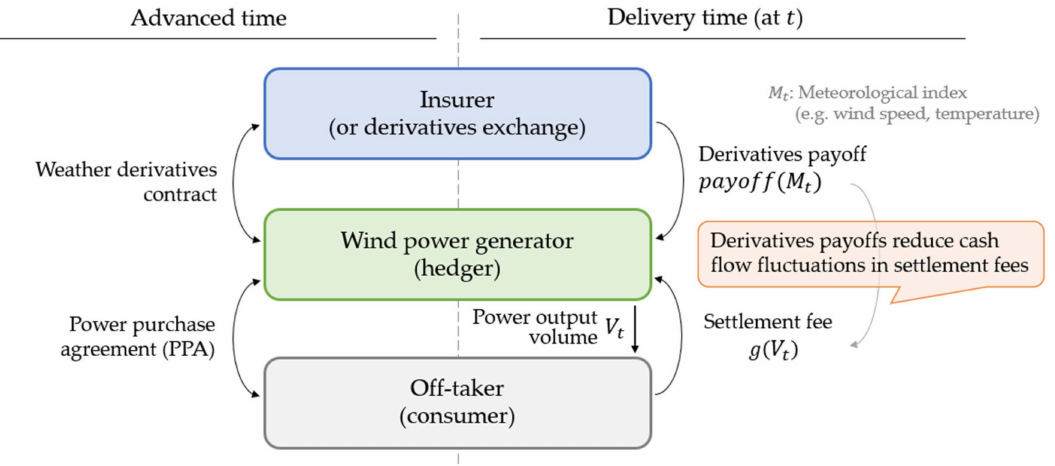
Figure 1. Overall picture of the transactions assumed in this study (from derivatives contracts to